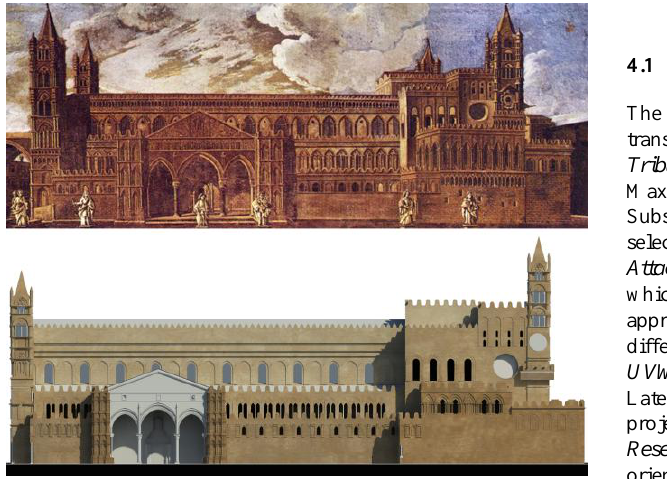
Fig. 6: Reconstruction of the southern front.